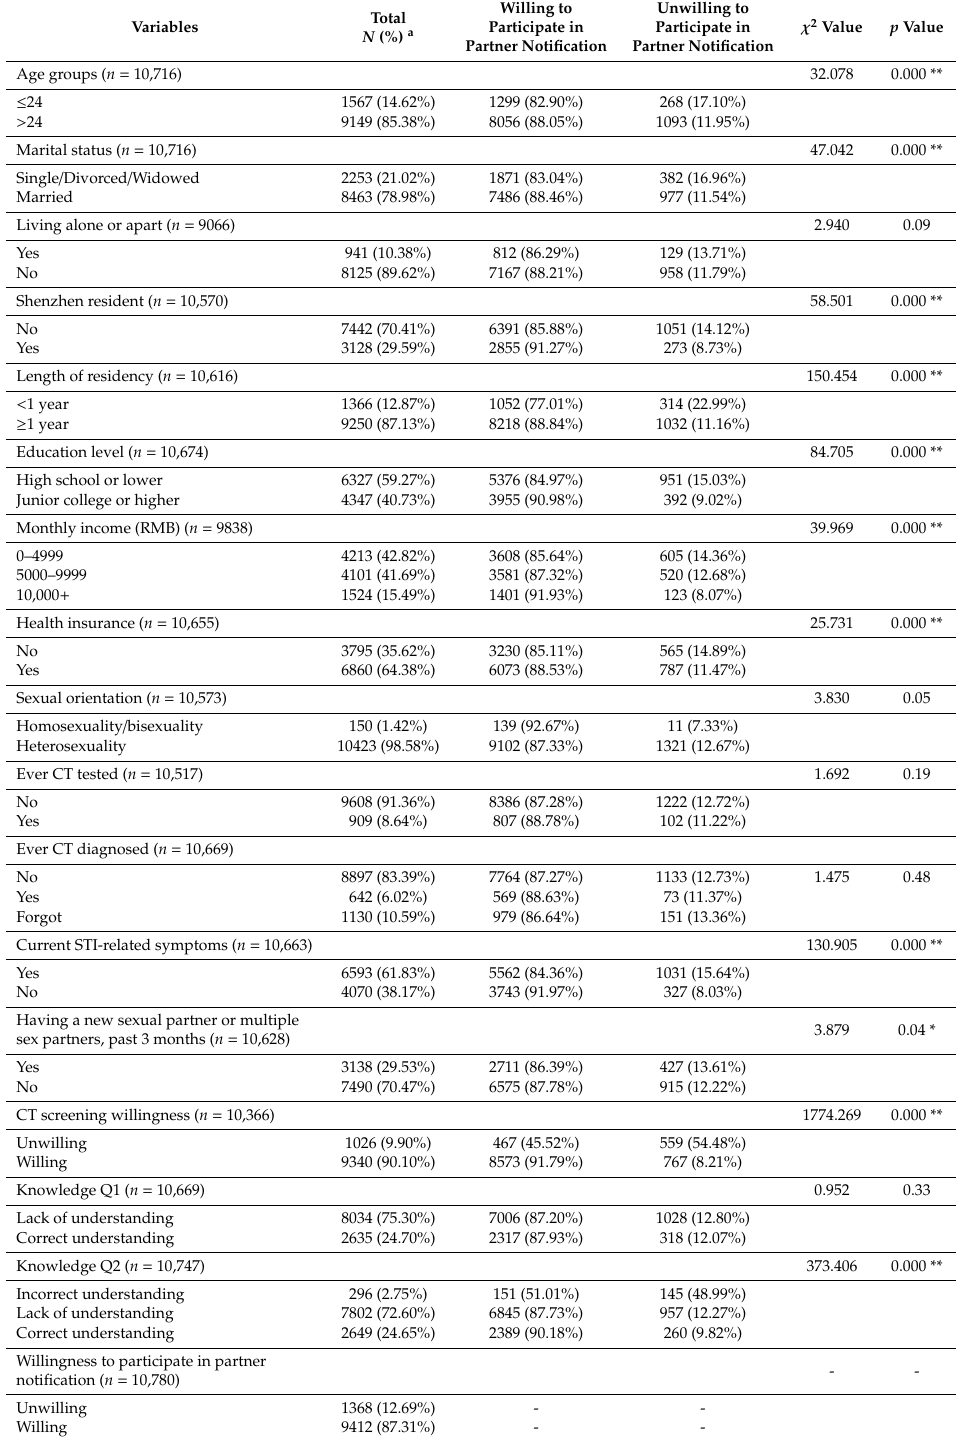
Table 1. Sociodemographic characteristics and STI histories of participants and the correlates with willingness to participate in partner